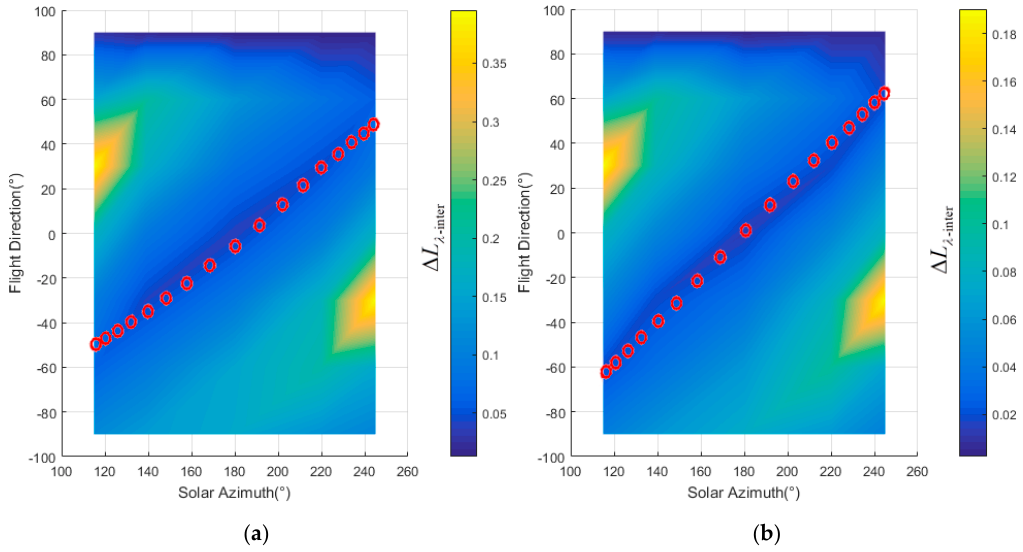
Figure 9. Radiance difference in the overlap area between adjacent stripes: (a) the radiance difference in zone A (b) the radiance difference in zone B.